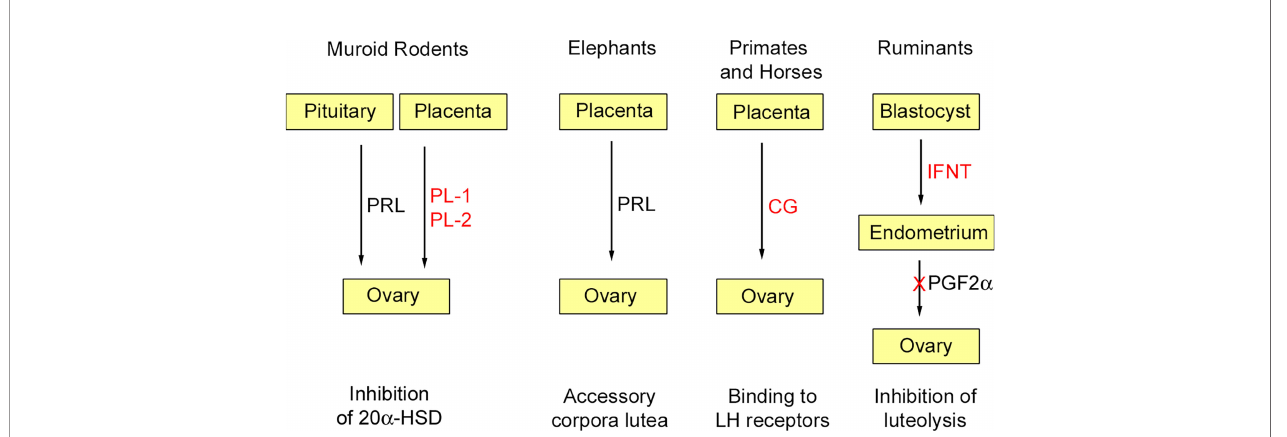
FIGURE 1 | Some luteotrophic factors. Those derived through gene duplication are shown in red. In murid and cricetid rodents (e.g., mouse, golden hamster) pituitary prolactin (PRL) is released in response to coitus and inhibits 20 a -hydroxysteroid dehydrogenase (20 a -HSD); subsequently this function is assumed by placental lactogens (PL-1, PL-2). In elephants, placental expression of PRL is responsible for pregnancy maintenance by accessory corpora lutea. In anthropoid primates and horses, chorionic gonadotropins (CG), derived through duplication of the luteinizing hormone b -subunit, are expressed by trophoblast and maintain luteal function in the early months of gestation. In ruminants, interferon-tau (IFNT) derived by duplication of the INFW gene is secreted by the blastocyst and acts on the endometrium to inhibit the luteolytic signal prostaglandin F 2 a (PGF2 a ). Reproduced from Physiological Reviews (2) Copyright © 2012, The American Physiological